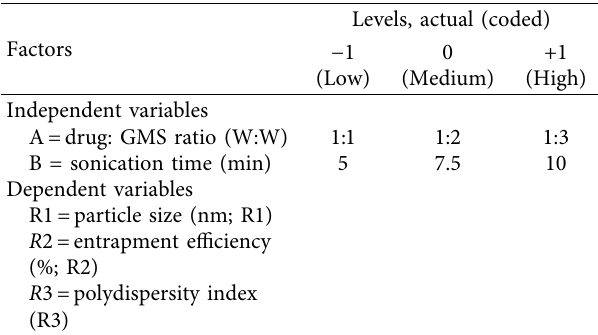
Table 1: Dependent and independent variables are taken in the optimization of